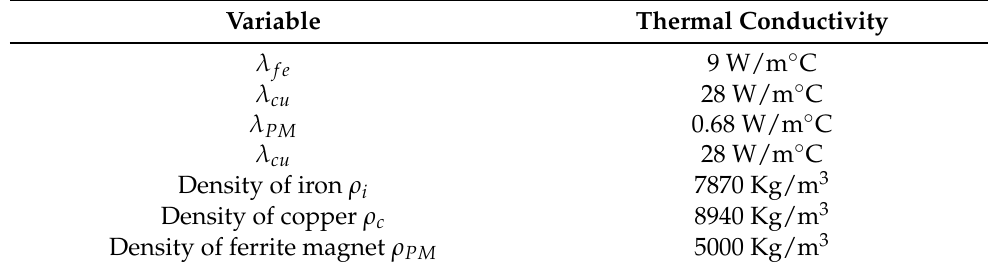
Table 8. Thermal conductivity of various parts.